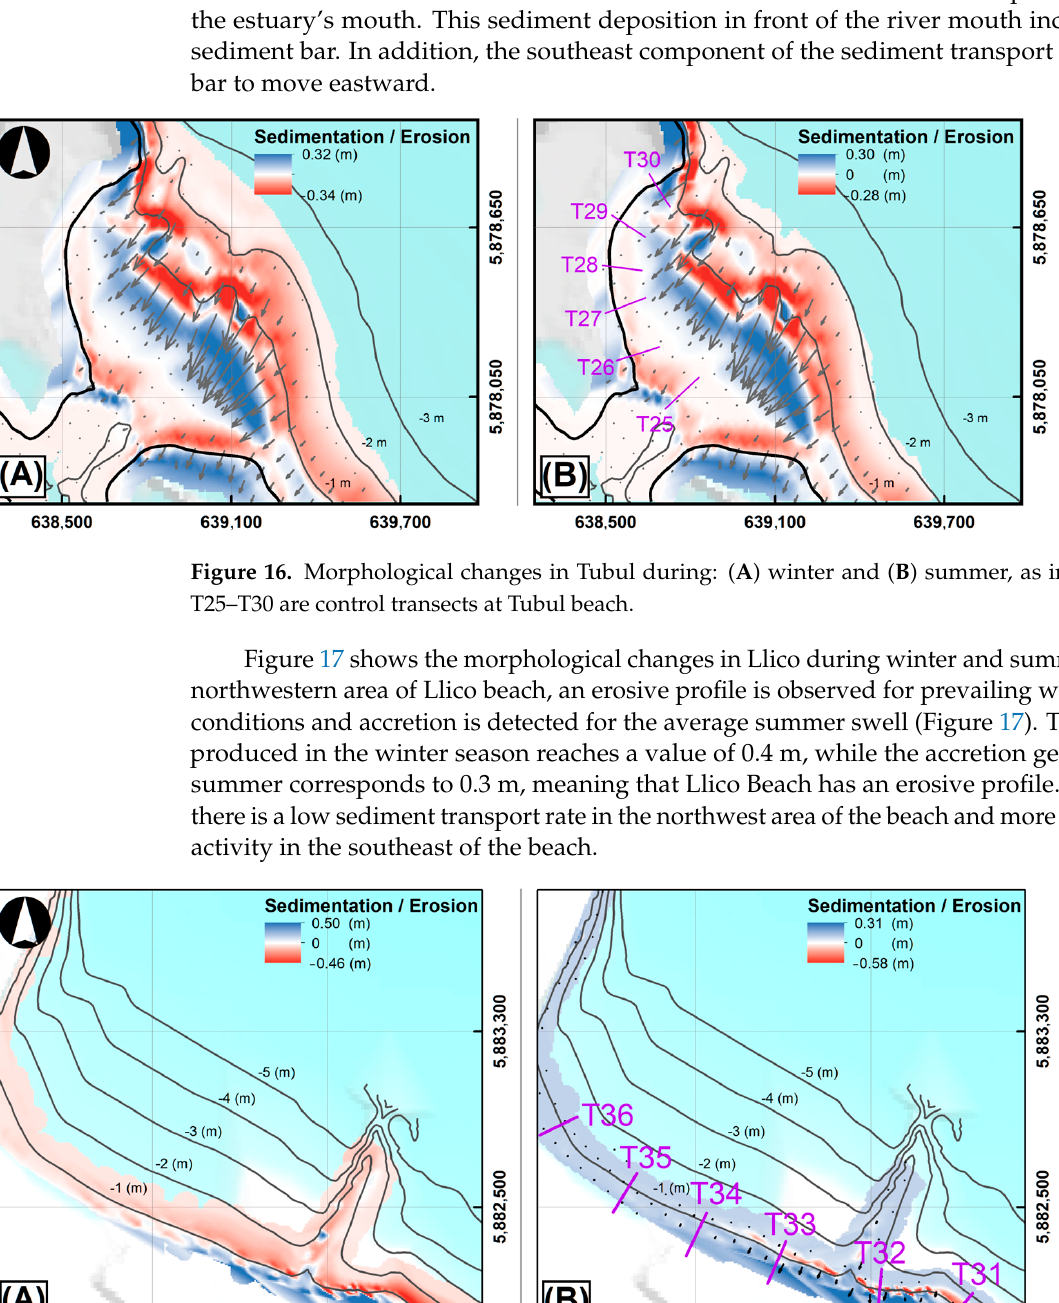
Figure 15. Morphological changes in Arauco during: ( A ) winter and ( B ) summer. Arauco beach is divided into two zones: east (blue box) and west (red box), as in Figure 13. T19-T24 are control transects at Arauco beach.